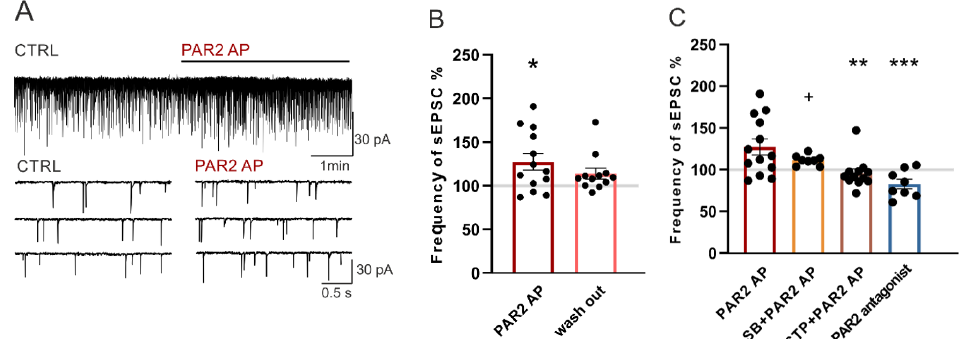
Figure 3. PAR2 activation increased the frequency of the spontaneous excitatory postsynaptic currents (sEPSCs) under the inflammatory conditions. ( A ) Application of PAR2 AP (4 min) on an acute spinal cord slice prepared 24 h after the carrageenan injection increased the sEPSC frequency as documented in the recording from one superficial dorsal horn neuron. ( B ) Application of PAR2 AP increased the average sEPSC frequency ( n = 13; Kruskal-Wallis one-way ANOVA, * p < 0.05). ( C ) Pretreatment and co-application of the TRPV1 antagonist SB 366791 (SB, n = 8) attenuated the PAR2 AP-induced effect on the sEPSC frequency. Pretreatment and co-application of staurosporine (STP, n = 12) prevented the excitatory effect of PAR2 AP. Application of the PAR2 antagonist ( n = 8) decreased the frequency of the sEPSC. Statistical analysis: one-way ANOVA followed by SNK test. Statistical symbols: ** p < 0.01 and *** p < 0.001 versus PAR2 AP and + p < 0.05 versus the PAR2 antagonist.